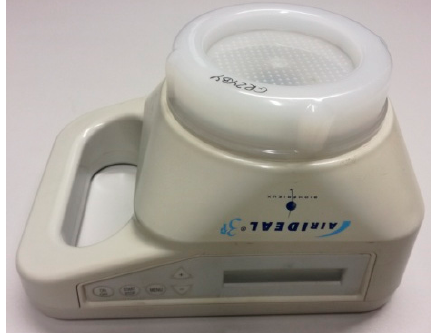
Figure 2. Air Ideal (AI) one-stage impactor used during the study.